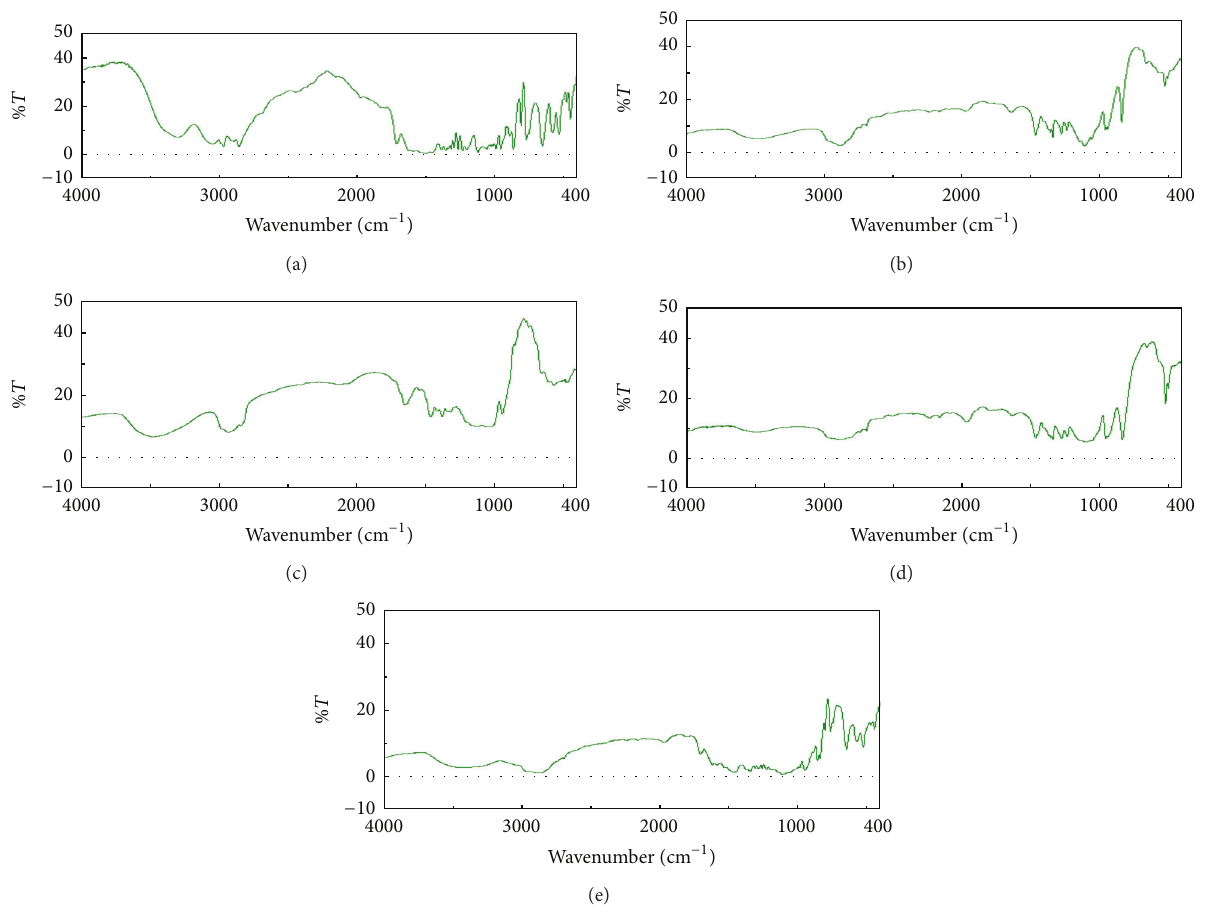
Figure 2: IR spectra of (a) timolol maleate, (b) HPMC + PF 27, (c) HPMC, (d) PF 127, and (e) timolol maleate + HPMC + PF 127.